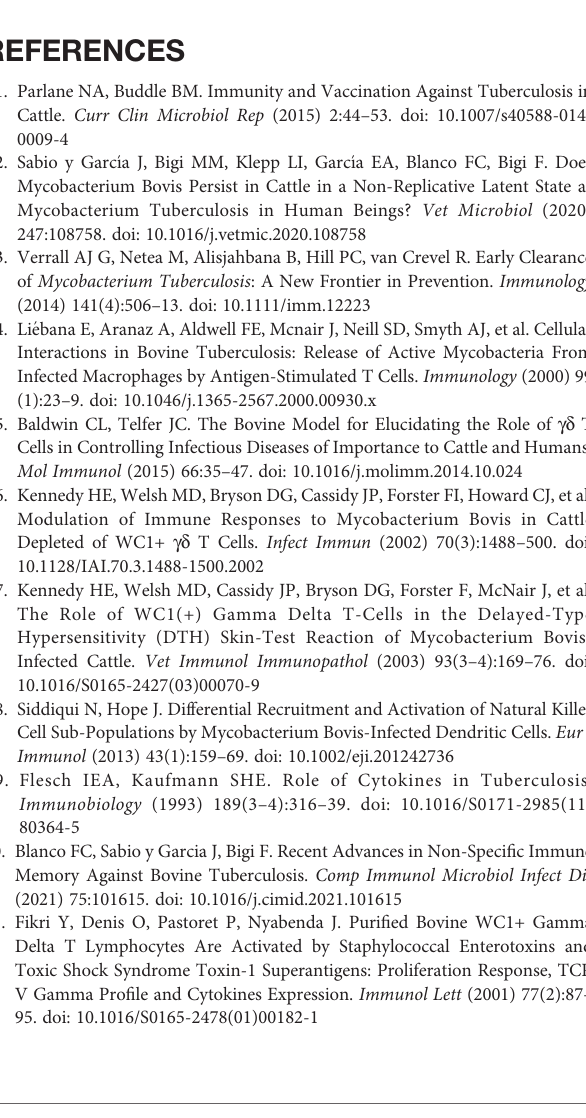
Supplementary Figure 3 | Cell viability evaluation for the mycobacterial growth inhibition assay in macrophages and co-cultures with autologous lymphocytes (+PBMC) infected with the different M. bovis strains (A) and for lymphocytes (B) stimulated with lyophilized bacterial culture media supernatant (CS). Supplementary Figure 4 | Lipid analysis of M. bovis strains (A) LC-MS analysis of secreted total lipids from M. bovis strains. (B and C) Thin-layer chromatograms of lipids fromculturesupernatantsof M.bovis strains.Totallipidsanalyzedwitha9:1(v/v)mixture ofn-hexaneanddiethylether (B) or19:1(v/v)mixtureofchloroformandmethanol (C) as the developing solvents. The arrows indicate the location of phthiocerol dimycocerosate (B) andmycoside (B C) as describedin(22).20 ×20cm ×0.5-mm layersofsilicagelG were used and chromatograms were sprayed with CuSO4 heated with heat gun. Supplementary Figure 5 | Western blot analysis in total secreted proteins from M. bovis strains with polyclonal a -ESAT-6. (1) Mb534::ESAT6 (2) Mb534:: ESAT6T63A. Arrows indicate the position of ESAT-6 monomers and multimers. Supplementary Figure 6 | In vivo interaction of ESAT-6 alleles. Growth of co- transformed E. coli BTH101 strains in medium supplemented with maltose as sole carbon source. (A) signi fi cant difference between 1 and 2 (p<0.0001); (B) 1 and 3 (p<0.0001); (C) 1 and 4 (p<0.0001); (D) 2 and 3 (p<0.0001, p<0.05 at day 4); (E) 2 and 4 (p<0.0001) and (F) 3 and 4 (p<0.0001, p<0.001 at day 4). Supplementary Table 1 | Primers for real time